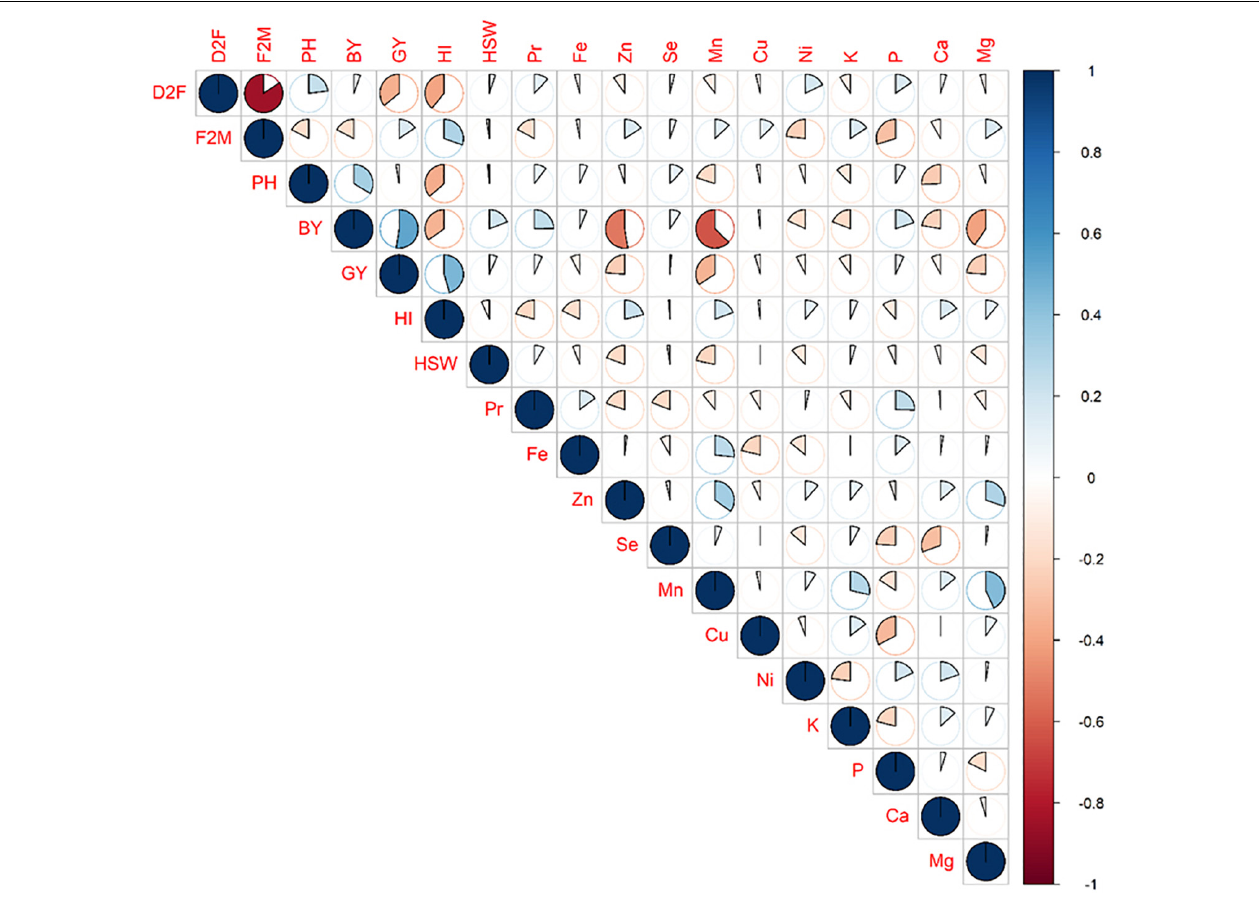
FIGURE 7 | Pearson matrix and correlations between agro-physiological and nutritional quality parameters. Positive correlations are displayed in blue and negative correlations in red. The spot size and color intensity are proportional to the correlation